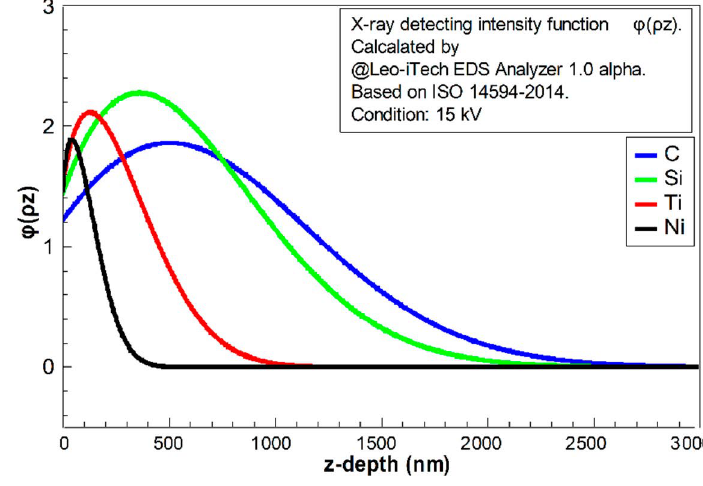
Figure 4. The relative intensity integral of X-ray with depth (z to infinity) calculated using the Leo-iTech EDS Analyzer 1.0 alpha for C, Si, Ti, and Ni, based on ISO 14594-2014, at voltage 15 kV.